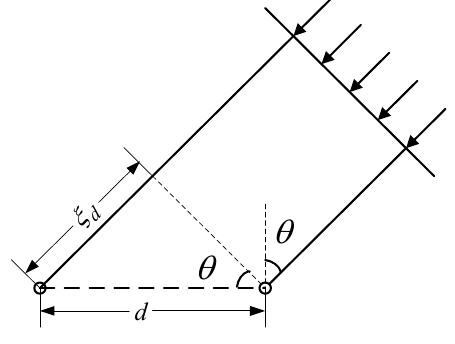
Figure 1. Schematic diagram of acoustic array with two